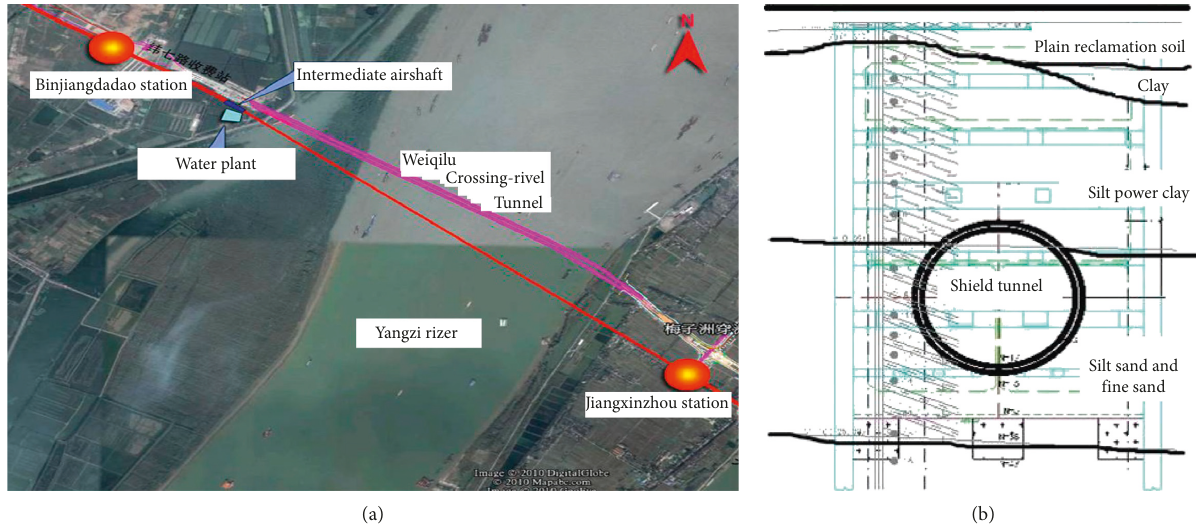
Figure 1: River tunnel of Nanjing subway Route-10: (a) plan view; (b) strata distribution of east shield launching